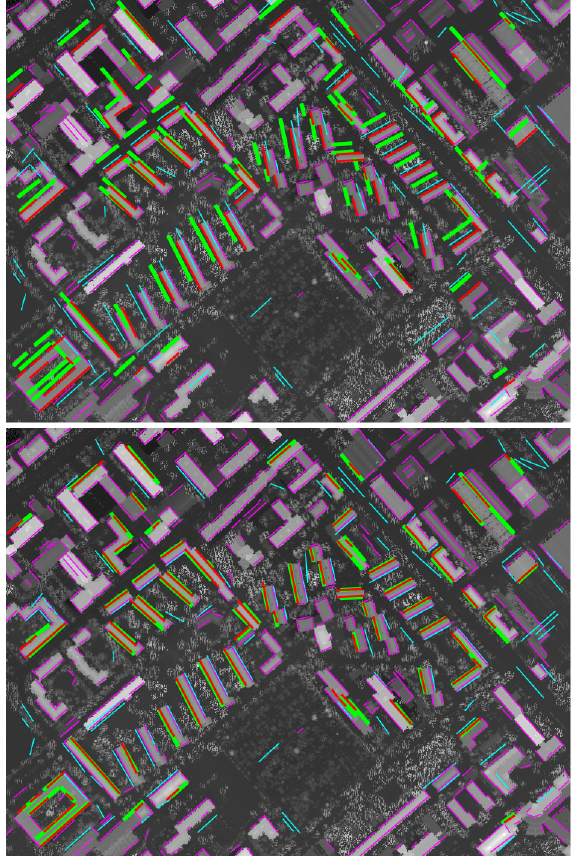
Figure 4: Detected lines in LiDAR DSM and HSI, before (top) and after coregistration (bottom). Line colours as described in Fig. 3.